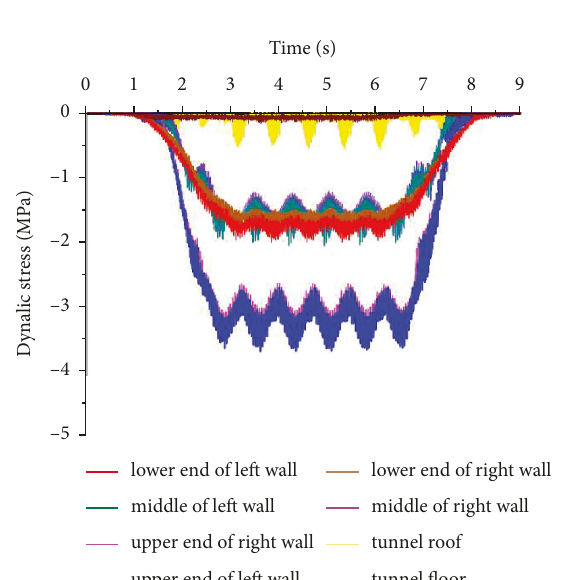
Figure 10: Time-history curve of dynamic tensile stress at each part of the left tunnel cross